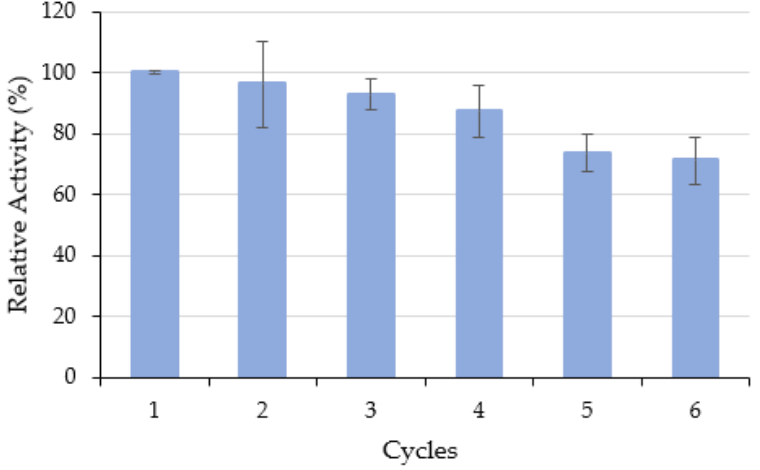
Figure 5. Operational stability of 0.26 mg·mL −1 of ASNase immobilized onto 2 mg of CX-4 at pH 6.7 over 49 min of contact time. Error bars represent the standard deviation.